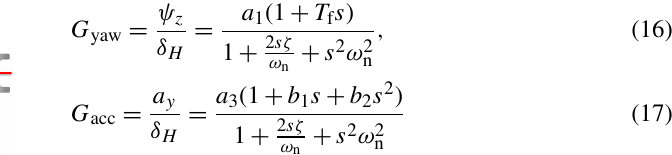
Figure 11. Trailing arm stress distribution contours.